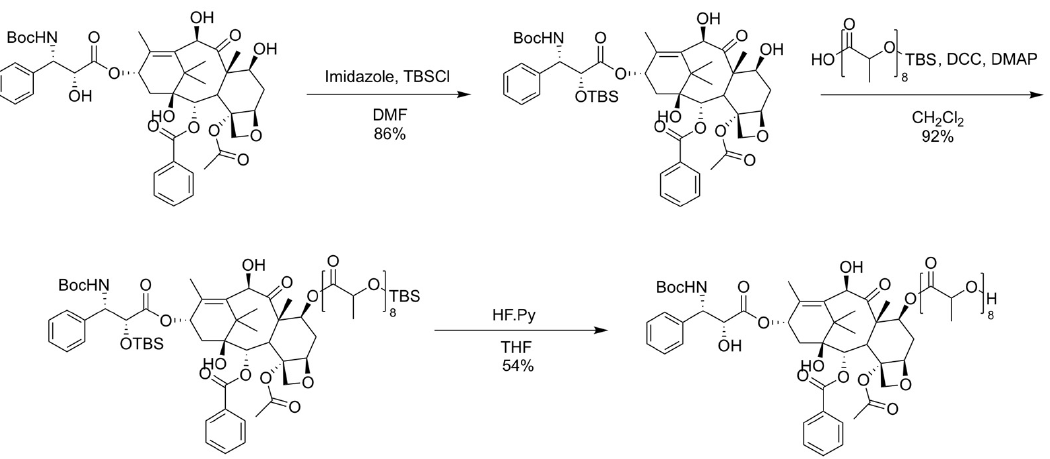
Figure 2. Synthetic route of o(LA) 8 -DTX prodrug.